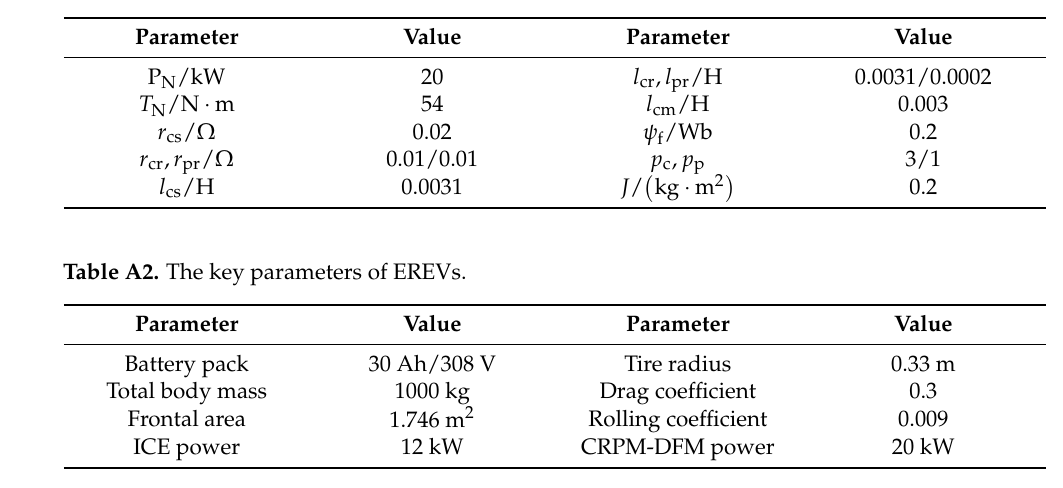
Table A1. Parameters of CRPM-DFM.